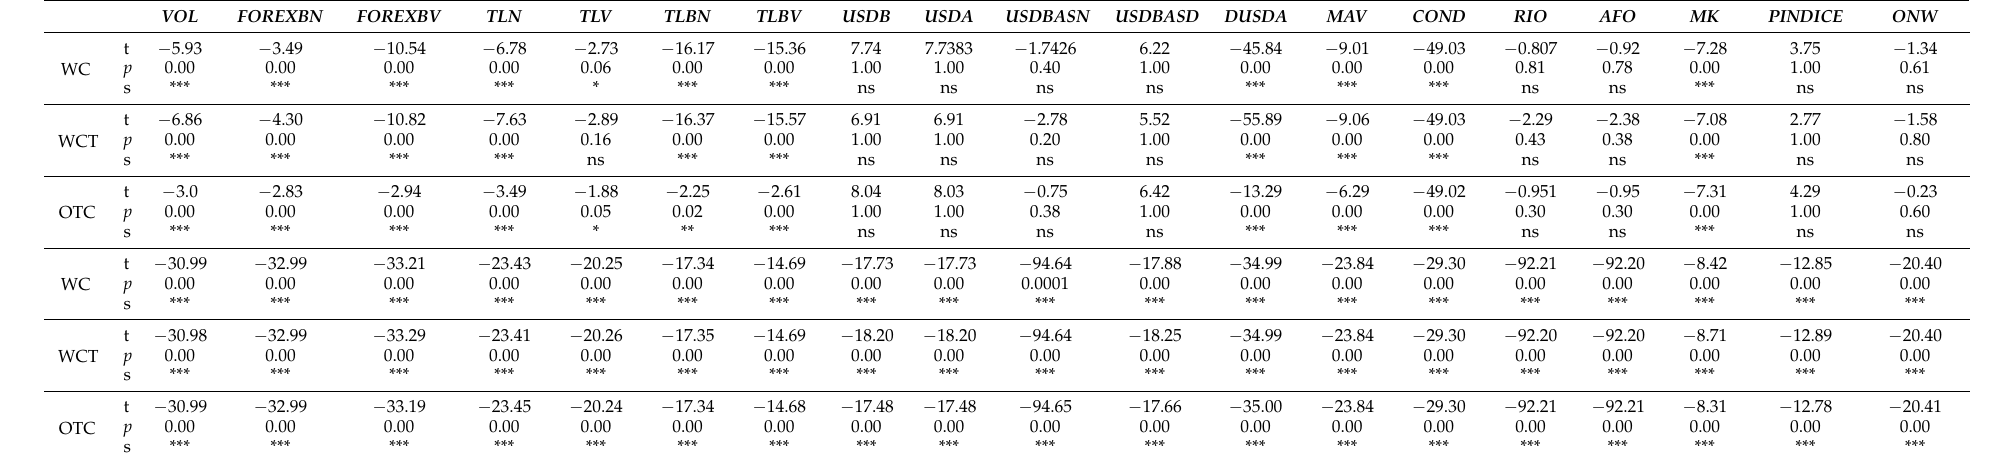
Table 3. Augmented Dickey–Fuller (ADF) unit root test